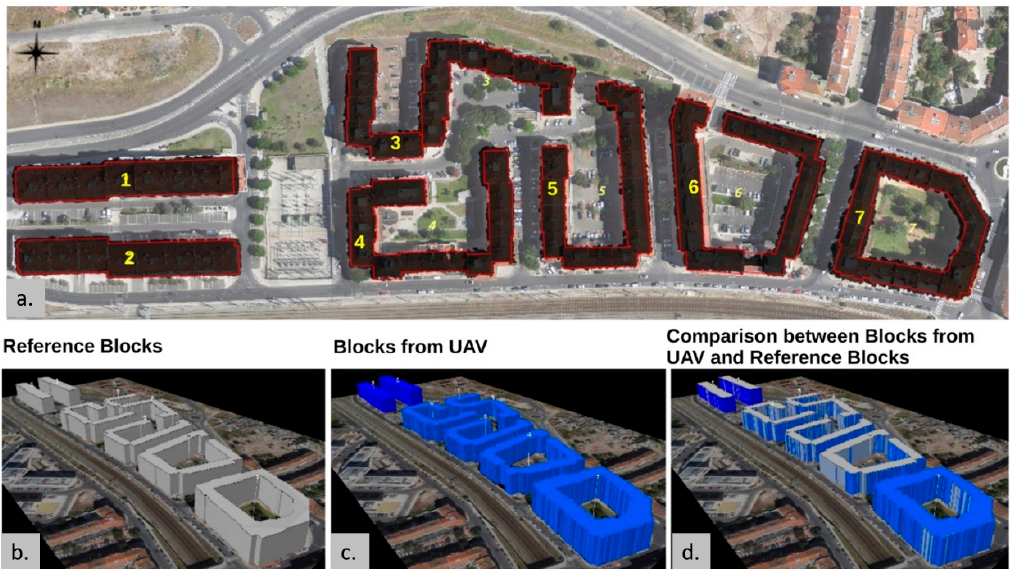
Figure 8. 2D / 3D comparison between reference data and data estimated from UAV: ( a ) Building block footprints (red: Reference dataset; black: extracted from UAV dataset); ( b ) 3D block model obtained from reference dataset; ( c ) 3D block model obtained from UAV data and ( d ) combination of the two 3D models represented in b, c).